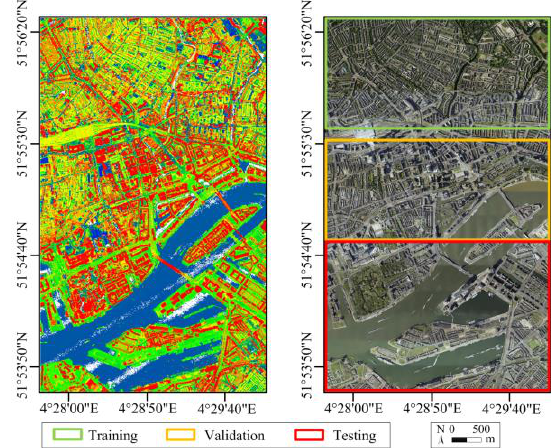
Figure 3. Study area. (a) ALS data colored according to point height. (b) Orthoimage colored based on true object color.